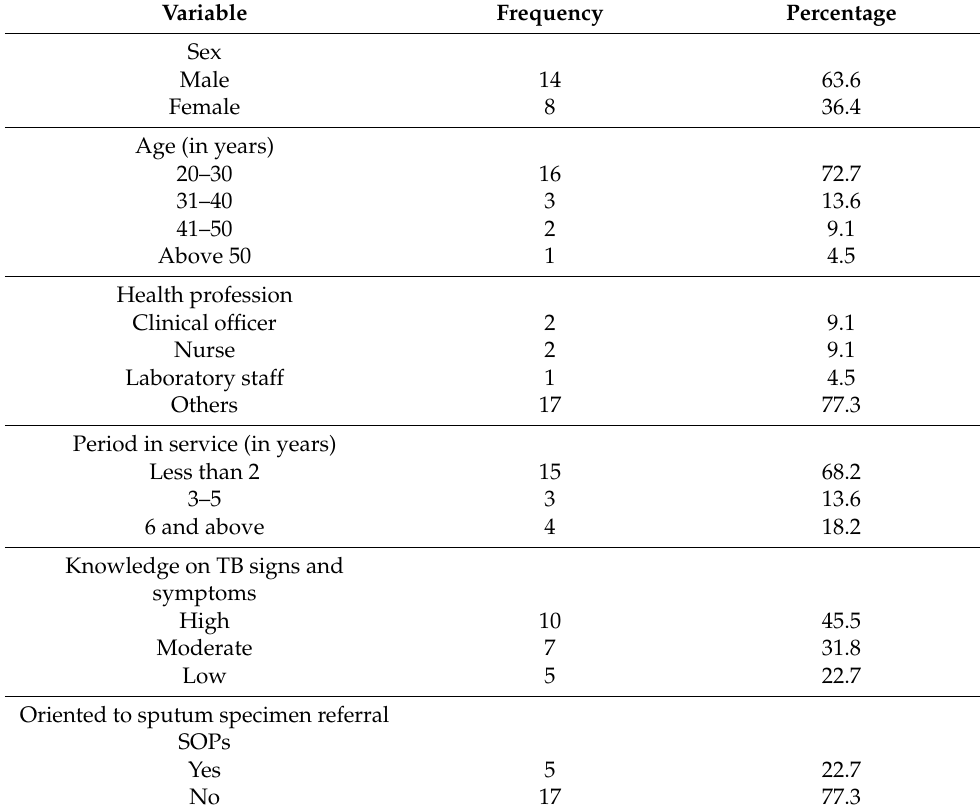
Table 1. Characteristics of TB service providers from ten non-diagnostic facilities in Mpulungu District, October 2018 ( N =